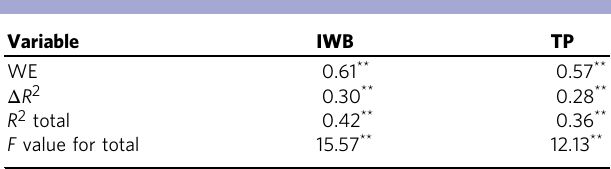
Table 5 Regression results in mediating the role of work engagement in innovative work behavior and task performance.